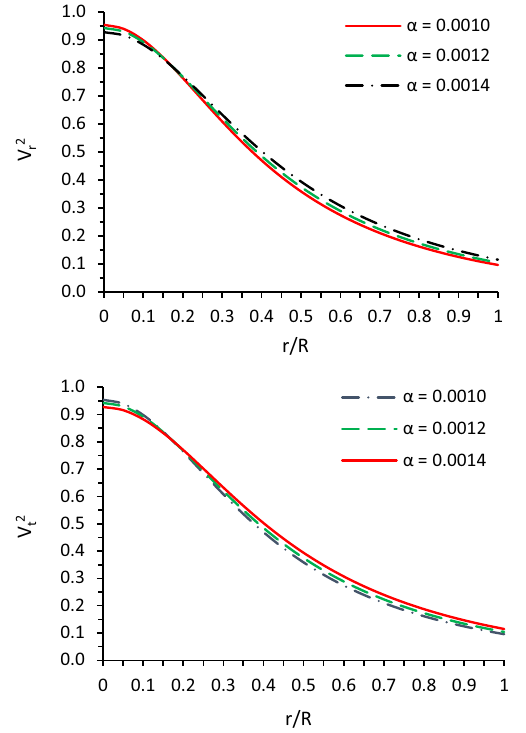
Fig. 5 The left panel has been plotted for radial speed (v 2 r ) and right panel for the tangential speed (v 2 t ) verses radial coordinate r / R of dif- ferentcompactobjectsasPSRJ1614-2230(blackcurvefor α = 0 . 001), 4U1608-52 (green curve for α = 0 . 0012), and Cen X-3 (red curve for α = 0 . 0014). The numerical values of the free parameters a , b , β and γ are same as used in Fig.